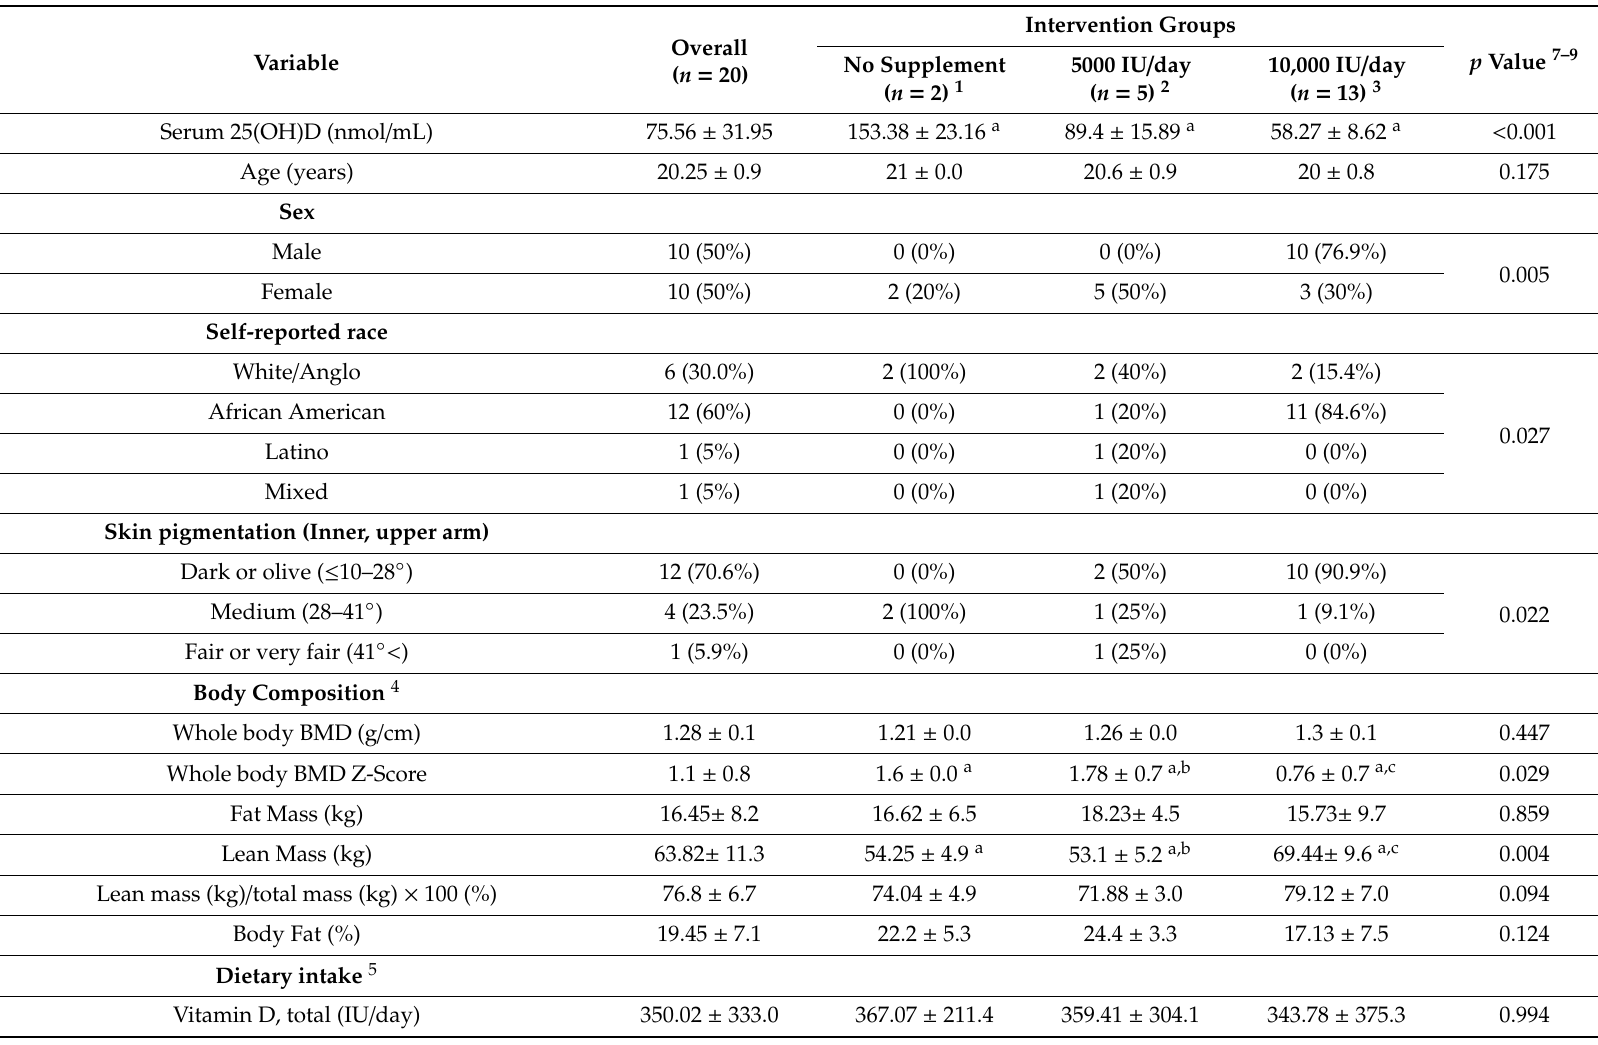
Table 2. Baseline characteristics of participants by intervention groups. Presented as mean ± SD for continuous variables and n (%) for categorical